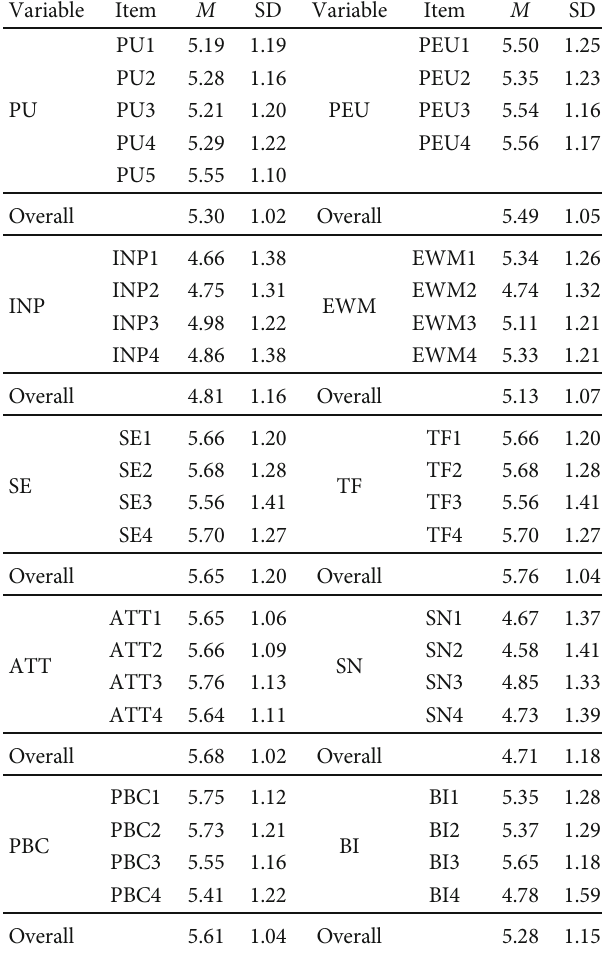
Table 1: Means and standard deviations of the research